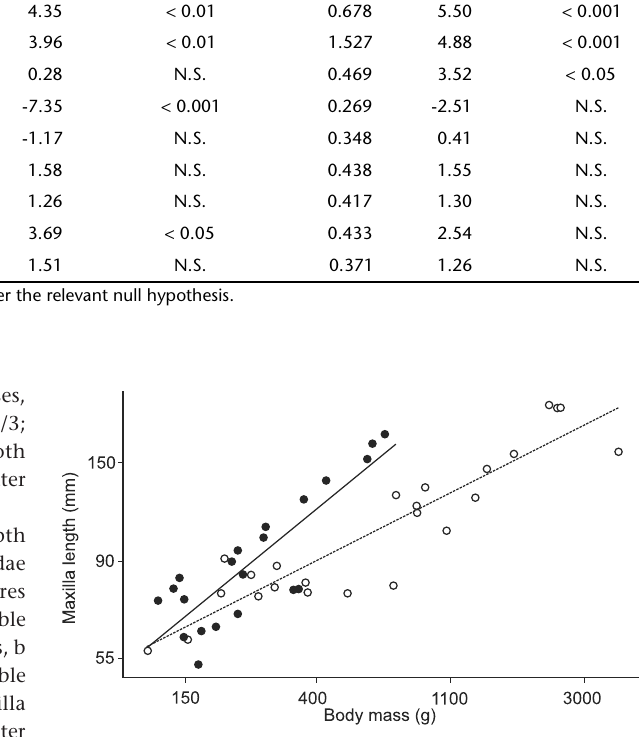
Figure 4. Maxilla length vs. body mass for toucans (solid circles) and hornbills (open circles) on a log scale, with OLS linear regres- sion lines: for toucans, Y = 1.460 + 0.551X (solid line; adj. R 2 = 71.0%, p < 0.001) and for hornbills: Y = 2.445 + 0.342X (dotted line; adj. R 2 = 84.0%, p <